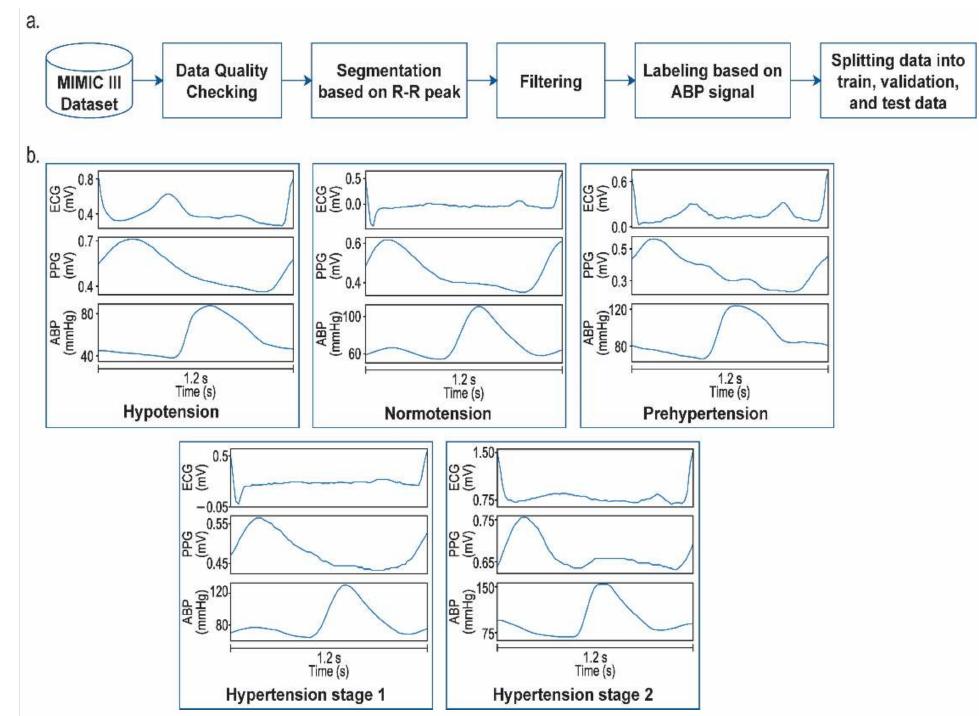
Figure 1. ( a ) The proposed preprocessing steps. ( b ) Preprocessing results.